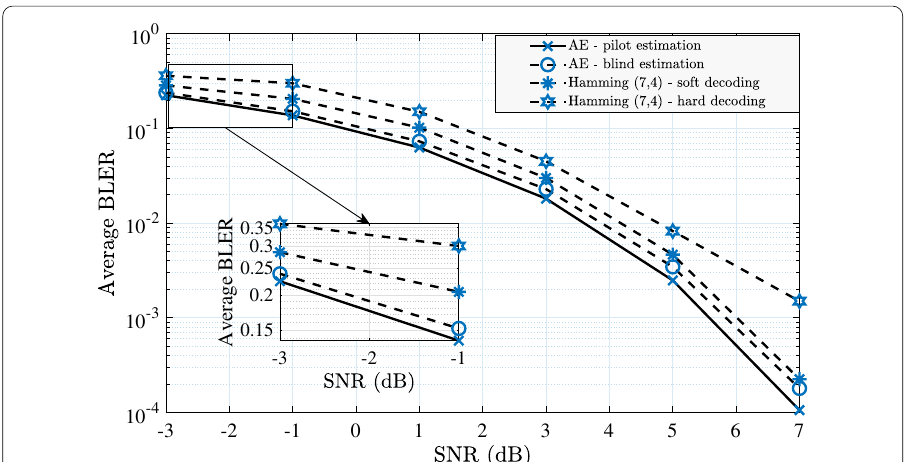
Fig. 3 Average BLER versus SNR when the instantaneous channel gain, i.e., pilot symbol method, and blind estimation method. The parameters for the AE are set as follows: M = 16 , L = 7 , and n = 5